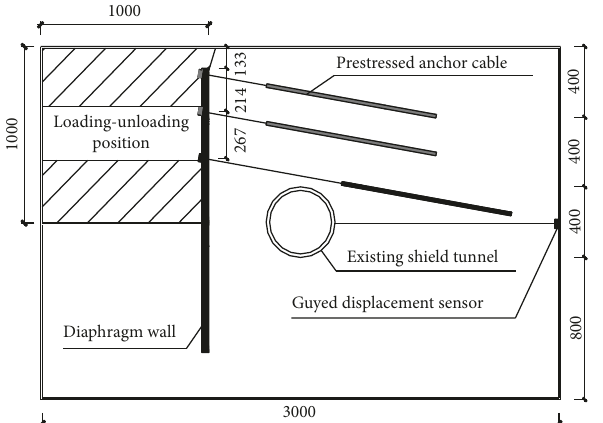
Figure 4: Layout of the support structure and sensor arrangement mode in scheme 0.